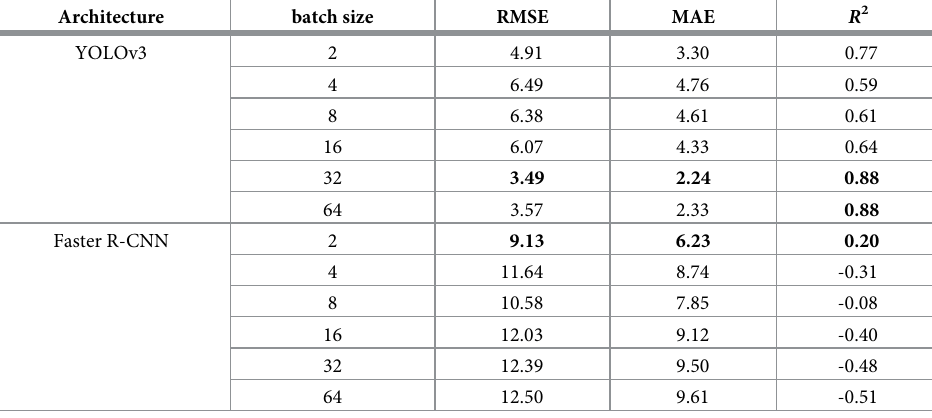
Bold font indicates the best results obtained by each